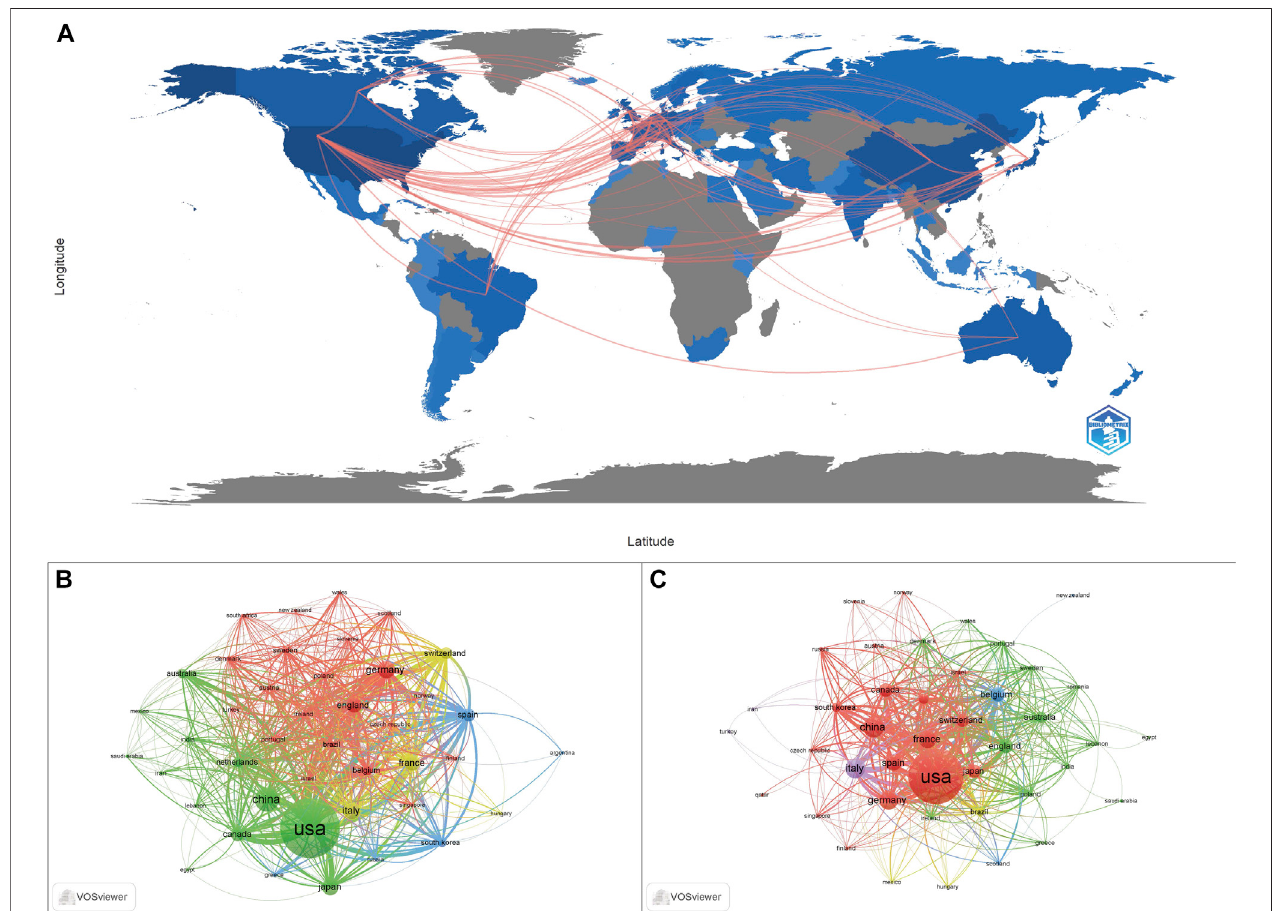
FIGURE2| Thegeographicaldistributionofthepublicationsandthecountrycollaborationnetworkmap. (A) Thegeographicaldistributionofpublicationsrelatedto ADC research. (B) Country collaboration in the holistic ADC research fi eld. (C) Country collaboration in the clinical ADC research fi eld.